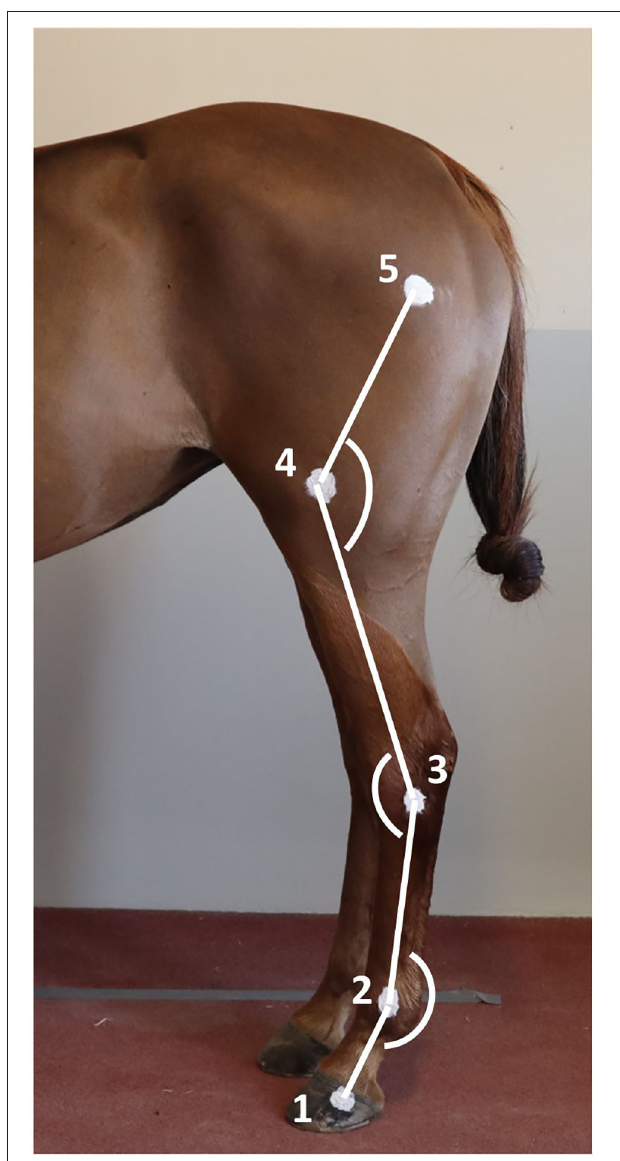
FIGURE 1 | Position of the markers on the hindlimb anatomical landmarks and angles measured. 1) Lateral hoof wall; 2) Lateral metatarsal epicondyle; 3) Lateral tubercle of the talus; 4) Lateral femoral epicondyle; and 5) Great trochanter of the